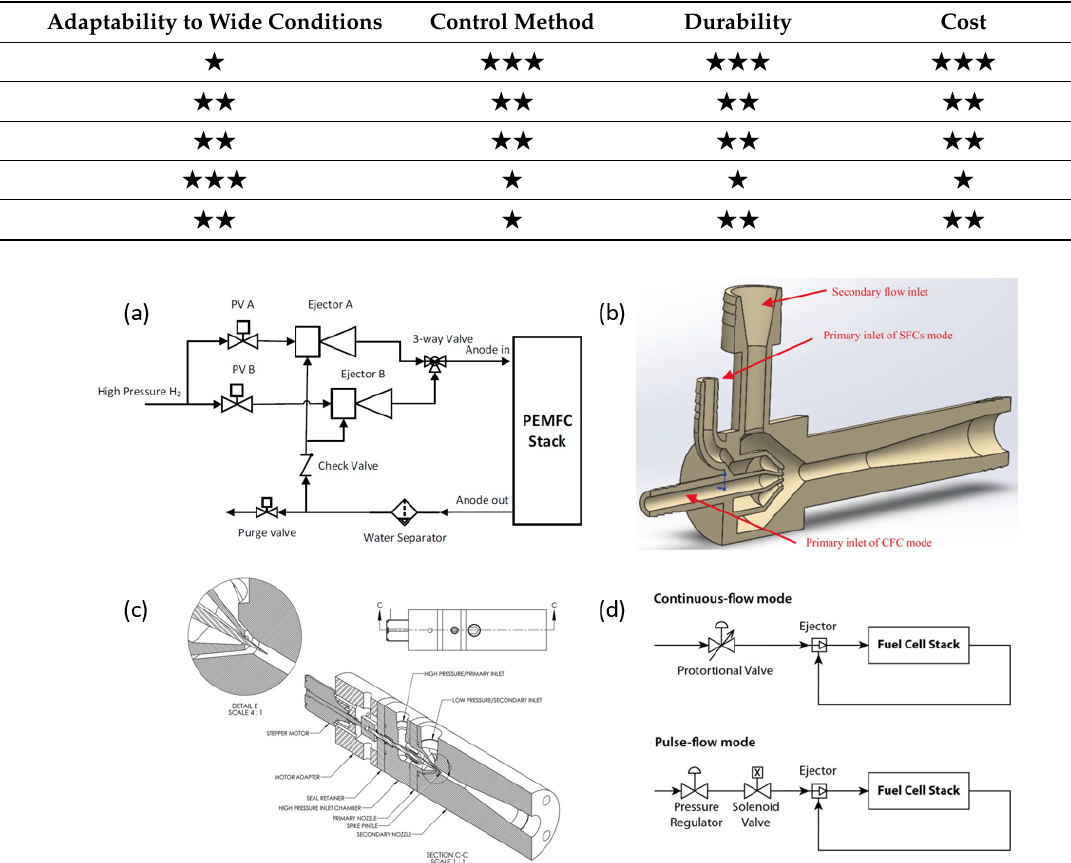
Table 1. Comparisons of different types of ejectors.